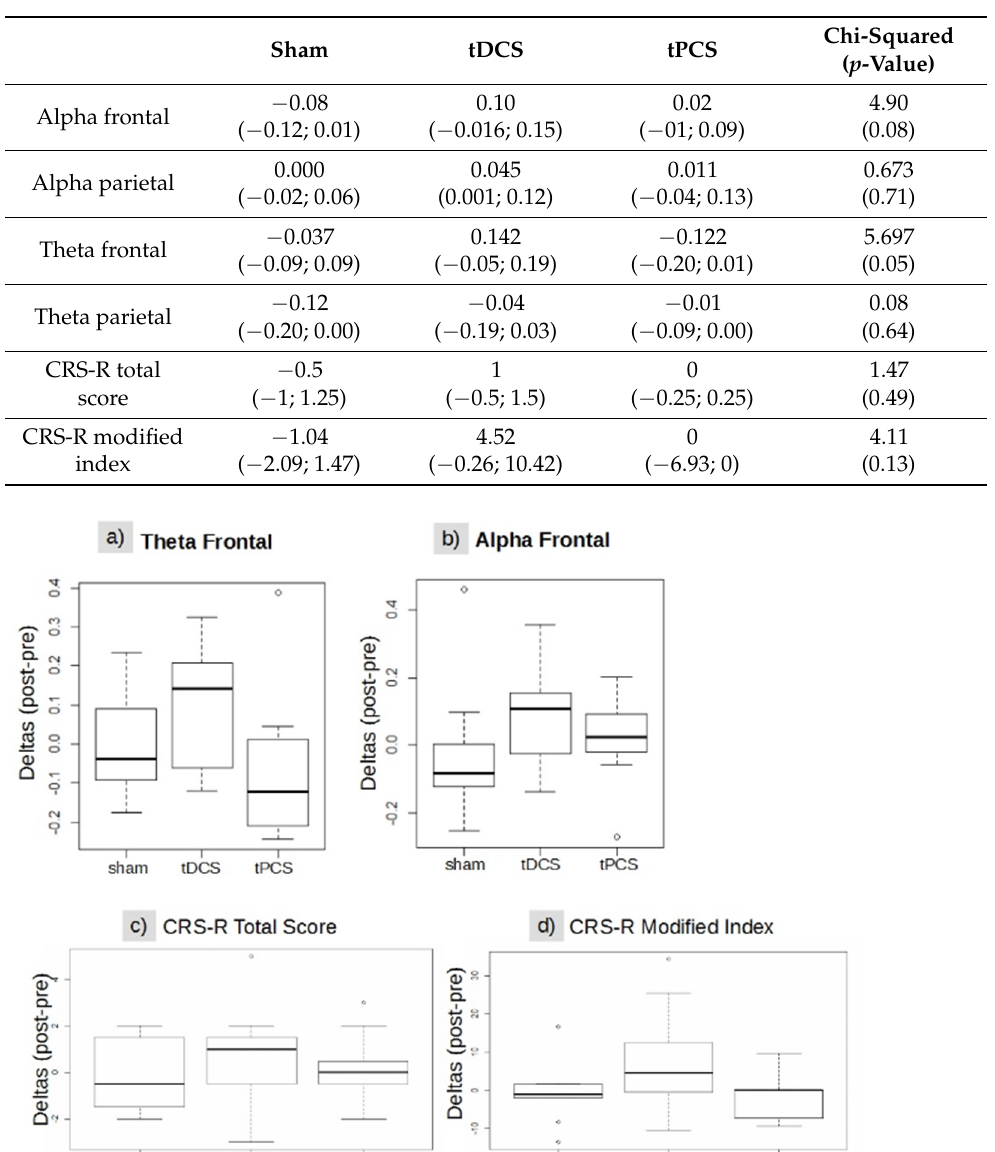
Table 2. Details on EEG Connectivity data and behavioral data. Cells report median and (IQR25—IQR75) of post- and pre-differences of EEG data (each band and region for each condi- tion; for example, alpha frontal median for sham condition was − 0.08 and IQR25 − 0.12, IQR75 0.01) and behavioral data (CRS-R total scores and modified index for each condition. For example, the median of CRS-R total scores for sham condition was − 0.5 and IQR25 − 1, IQR75 1.25). The last column reports the Chi-squared and p -value (between parentheses) for the Kruskal–Wallis comparing that band and region between conditions for the EEG data and the Chi-squared and p -value for the Kruskal–Wallis between conditions for behavioral data.